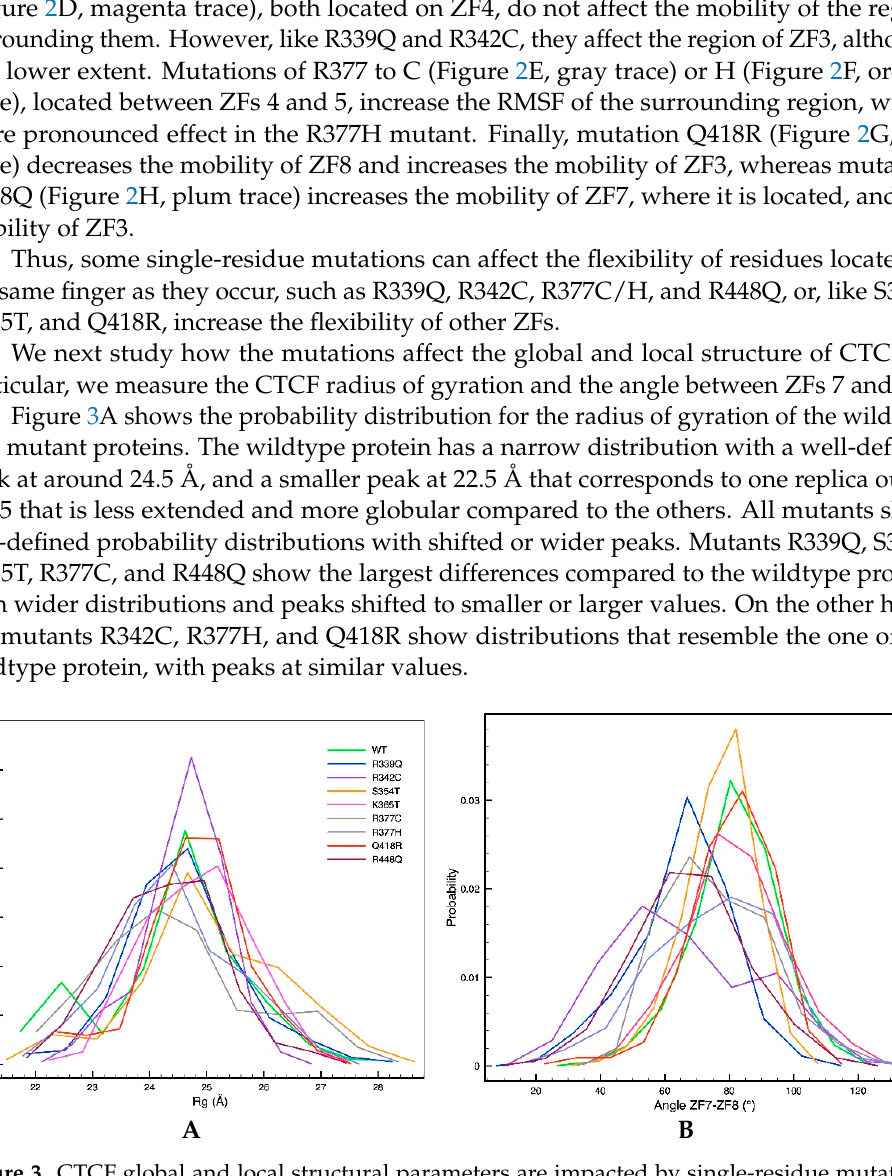
Figure 3. CTCF global and local structural parameters are impacted by single-residue mutations. ( A ) CTCF radius of gyration, and ( B ) angle between ZFs 7 and 8 for the wildtype (WT, green) and mutant proteins calculated using the last 100 ns of five trajectories per system.